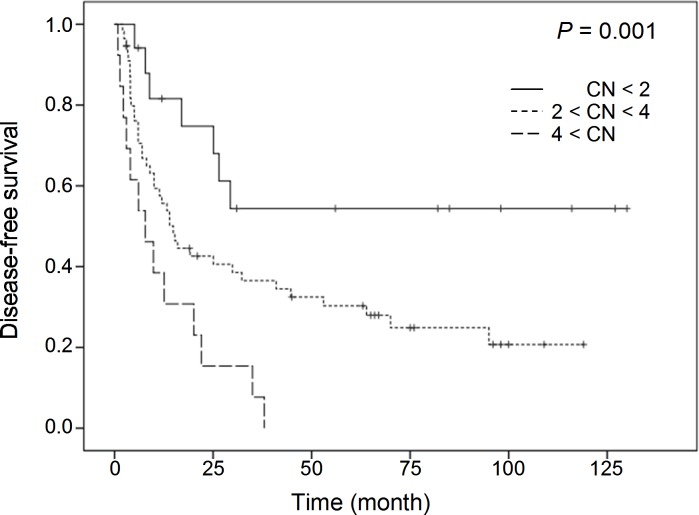
Kaplan-Meier survival curves for patients categorized by gene copy numbers.Statistical significance was observed among groups. (CN < 2: copy numbers less than two for all three markers of the 3-marker combination; 2 < CN < 4: copy numbers between two and four for at least one of three markers; 4 < CN: copy numbers more than four for all three markers)